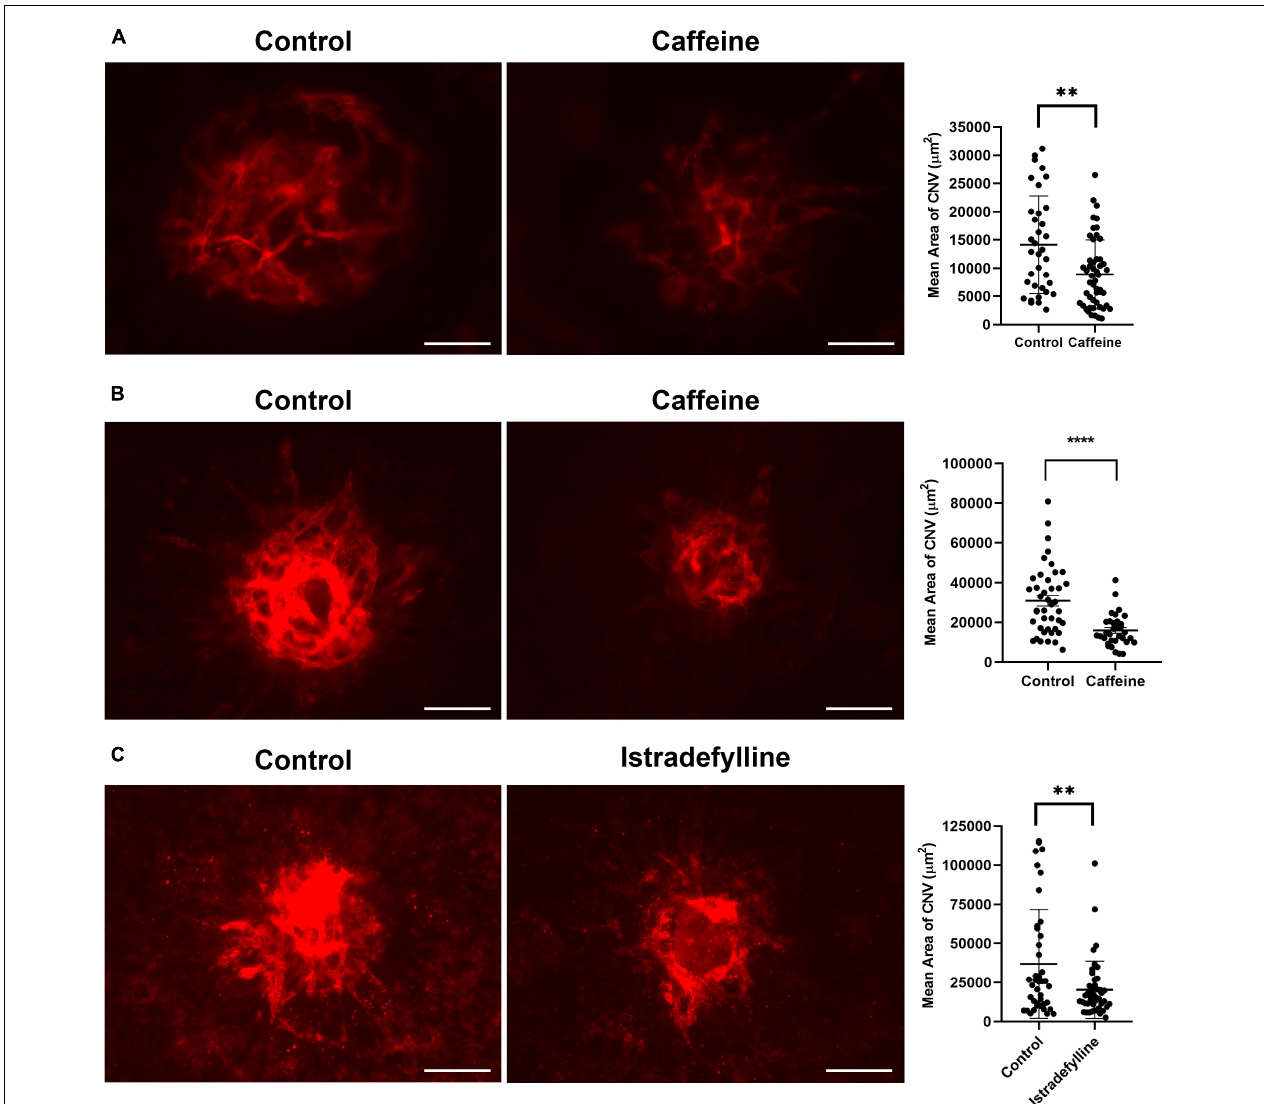
FIGURE 7 | Caffeine mitigates choroidal neovascularization (CNV). The 2-month-old (A) and 4- month-old mice (B) (C57BL/6j male and female) were gavaged with caffeine 20 mg/kg first dose and 10 mg/kg subsequent doses or vehicle starting 5 days prior to laser. Treatments continued until the choroid/RPE was harvested 2 weeks later and stained with anti-ICAM-2. A significant mitigation of choroidal neovascularization (CNV) was noted in mice treated with istradefylline (C) . Scale bar = 200 µ m (** p < 0.01, **** p < 0.0001; n = 10